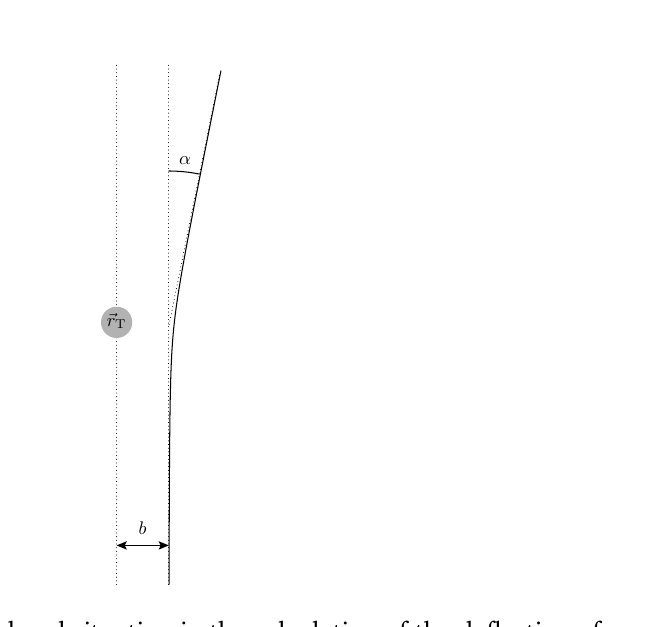
Figure 7: Sketch of the considered situation in the calculation of the deflection of a classical